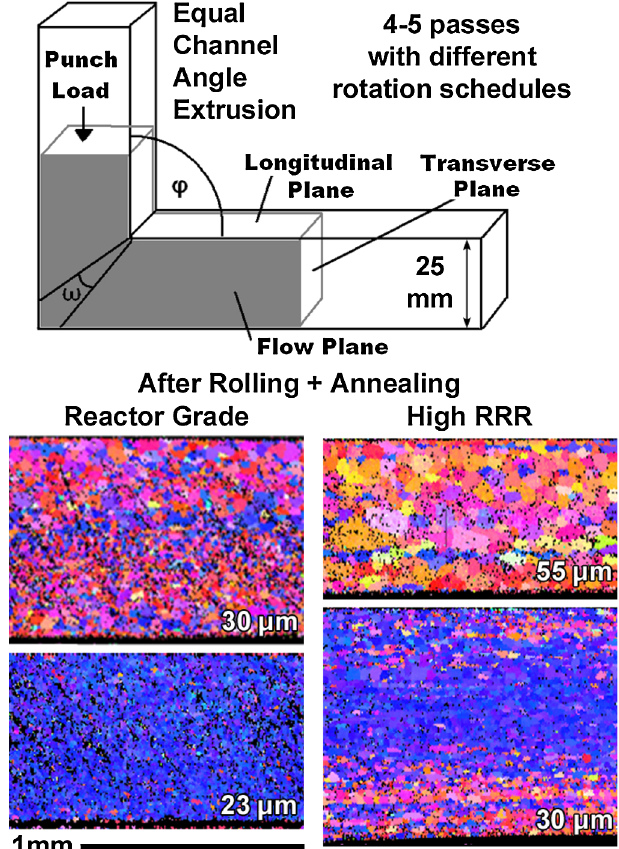
FIG. 11. (Color) Very different kinds of rolled sheet microstruc- tures and texture gradients can be obtained for samples prepro- cessed with ECAE ; the color scale is the same as Fig. 7 [25], and the white labels indicate a characteristic grain size.